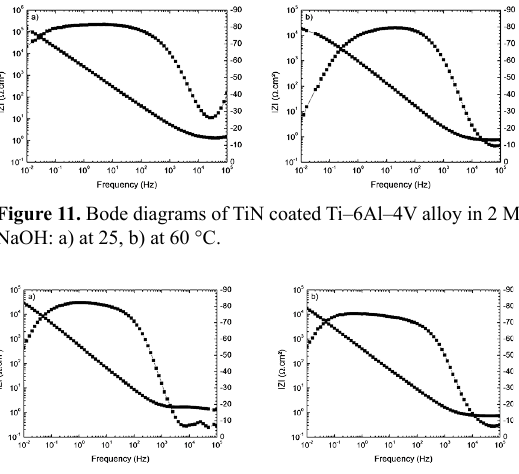
Figure 12. Bode diagrams of TiAlN/TiAlCrN coated Ti–6Al–4V alloy in 2 M NaOH: a) at 25, b) at 60